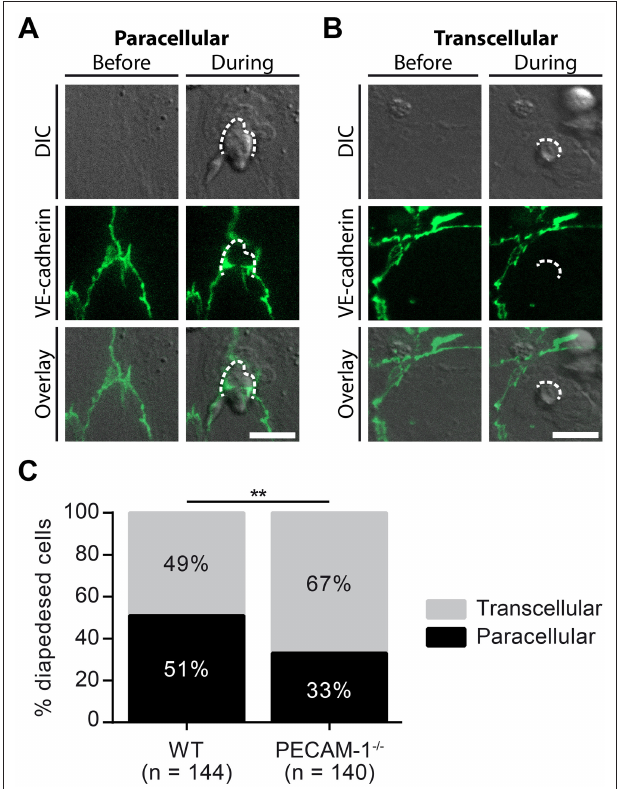
FIGURE 6 | Lack of endothelial PECAM-1 favors transcellular over paracellular diapedesis of encephalitogenic CD4 + T cells across pMBMEC monolayers under physiological flow. Confluent WT and PECAM-1 − / − VE-CadGFP pMBMEC monolayers were stimulated with IL-1 β (20ng/ml) for 16–24h prior to live cell imaging. Activated encephalitogenic CD4 + T cells were allowed to arrest on pMBMECs at low flow (0. 1 dyn/cm 2 ). After 5min, the flow was increased to 1.5 dyn/cm 2 . For time-lapse videos, pictures were taken every 30s for a total of 30min. For each diapedesis event, the transmigration route was determined as follows: An opening of GFP-expressing endothelial junctions was judged as paracellular diapedesis, while a sustained junctional integrity was indicative of transcellular diapedesis. (A,B) Representative pictures of paracellular (A) and transcellular (B) diapedesis taken before and during T-cell diapedesis. Dashed line, site of transmigration; scale bar, 10 µ m; DIC, differential interference contrast. (C) In total, 144 and 140T cells, which completely transmigrated through WT and PECAM-1 − / − endothelial monolayers, respectively, recorded in 68 videos (WT, 34 videos; PECAM-1 − / − , 34 videos) were analyzed. Reported statistics of categorical data result from Pearson’s qui-square test. Test statistics: p = 0.0016, χ 2 (1) = 9.991, odds ratio = 2.160; ** p < 0.01. In order to provide an estimate for data variability, a video-wise representation is provided in Supplementary Figure 2